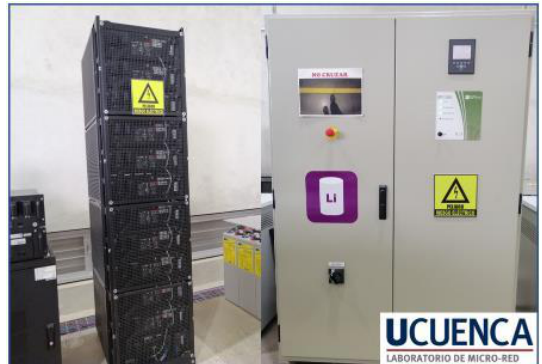
Figure A1. Lithium-ion BESS from the micro-grid laboratory: cell bank (left), power electronics converter cabinet (right).